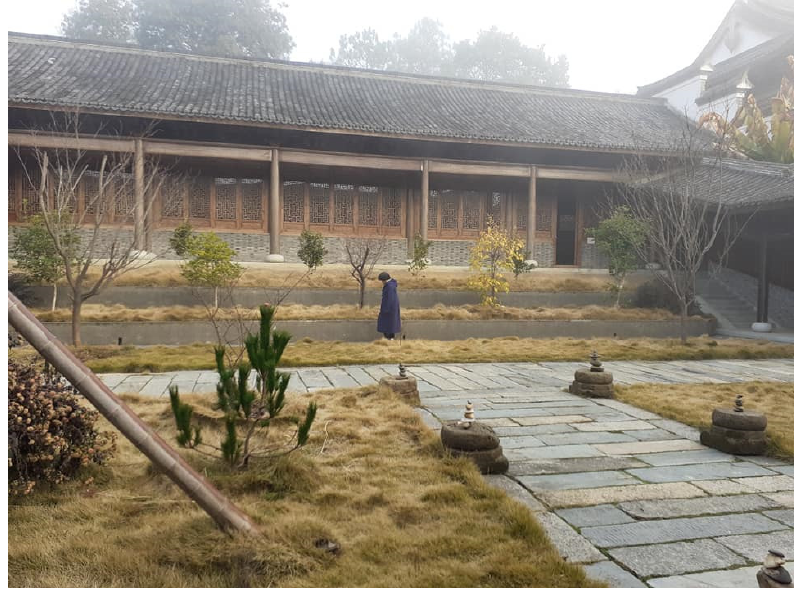
Figure 3. Walking meditation.